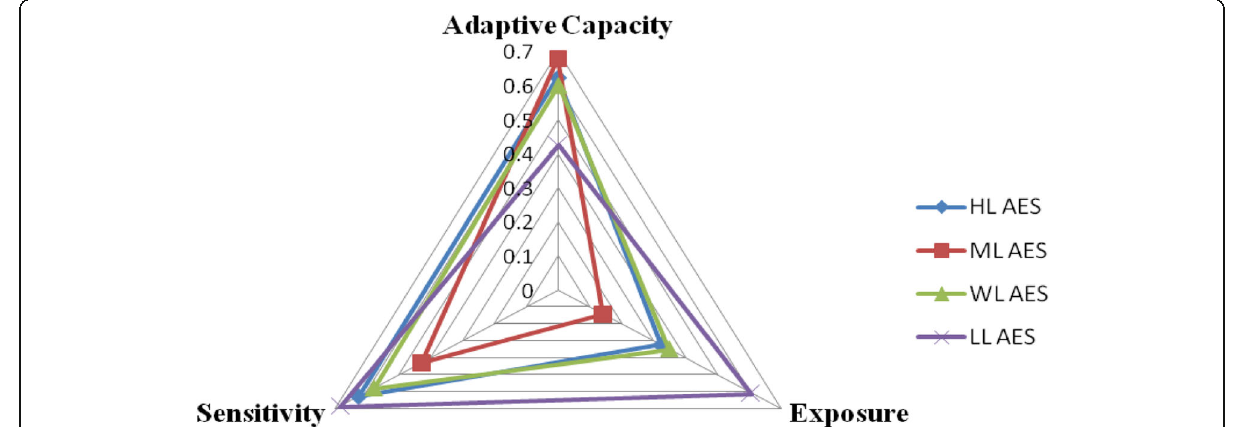
Fig. 3 Vulnerability triangle diagram of the dimensions of Climate Vulnerability Index